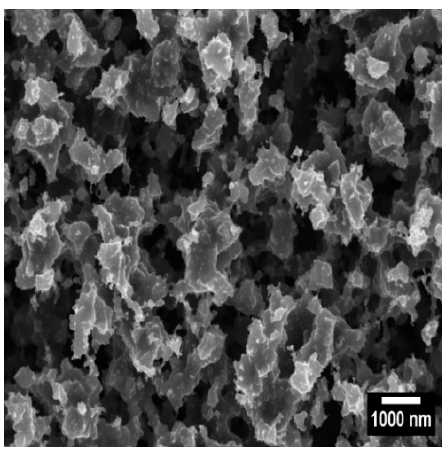
Figure 1. High-resolution scanning electron micrograph of the soot deposited during the controlled combustion of rapeseed oil at an air flow rate of 0.0035 m 3 /min.